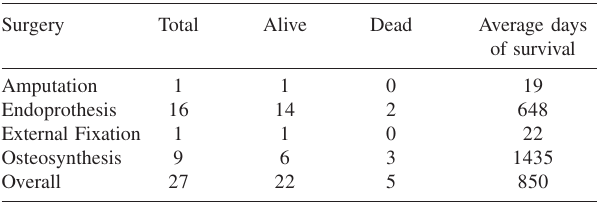
Table 7- Days of survival by type of surgical treatment Surgery